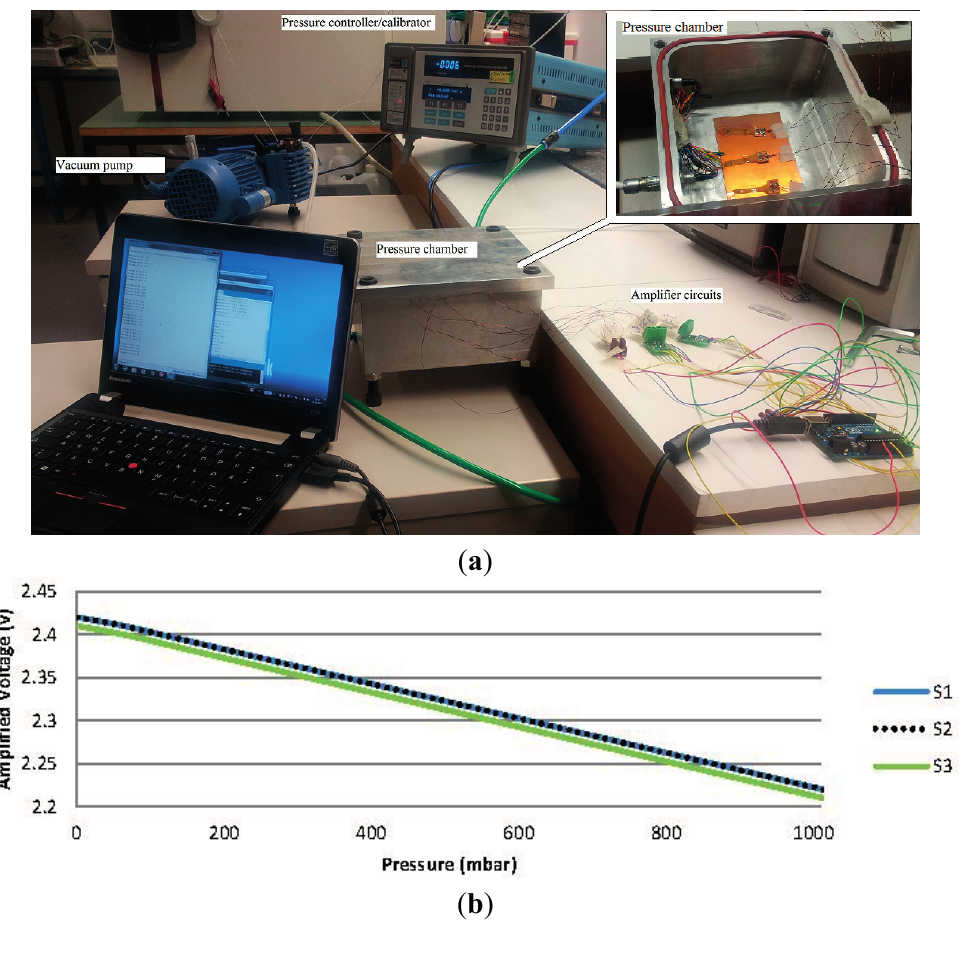
Figure 5. ( a ) Calibration setup consists of pressure chamber, vacuum pump, amplifier circuits, evaluation boards and a laptop; ( b ) calibration graph of piezoresistive pressure sensor for the range of 0–1020